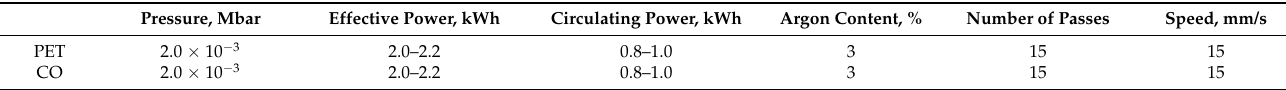
Table 2. Conditions of modification with Cu by magnetron